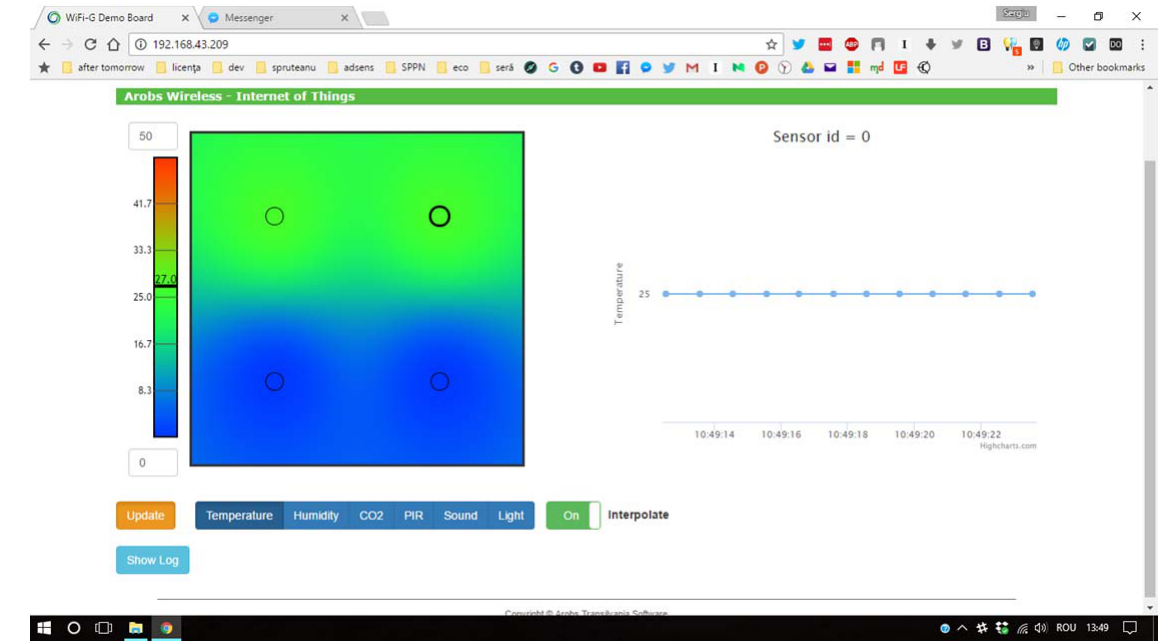
Figure 14. Web service for environmental data acquisition.